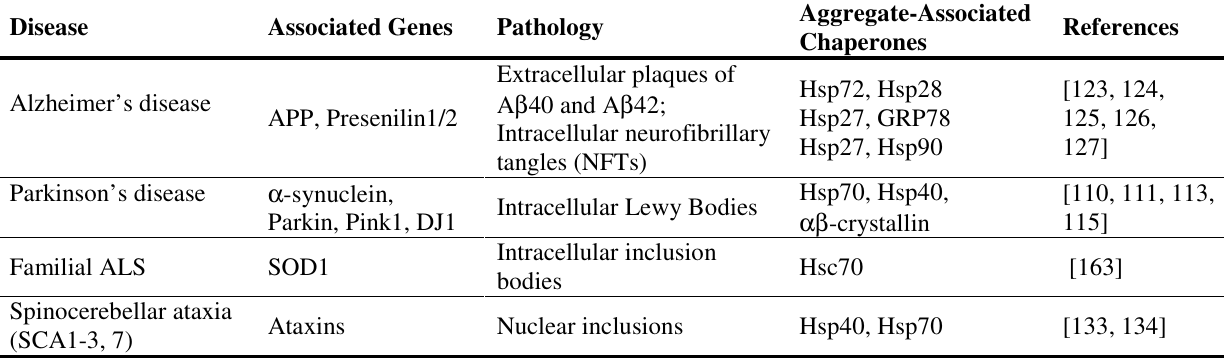
Table 1. Association of molecular chaperones with neurodegenerative disorders. Examples of common neurodegenerative diseases with chaperones shown to colocalize with respective protein aggregates either in disease tissue or in experimental